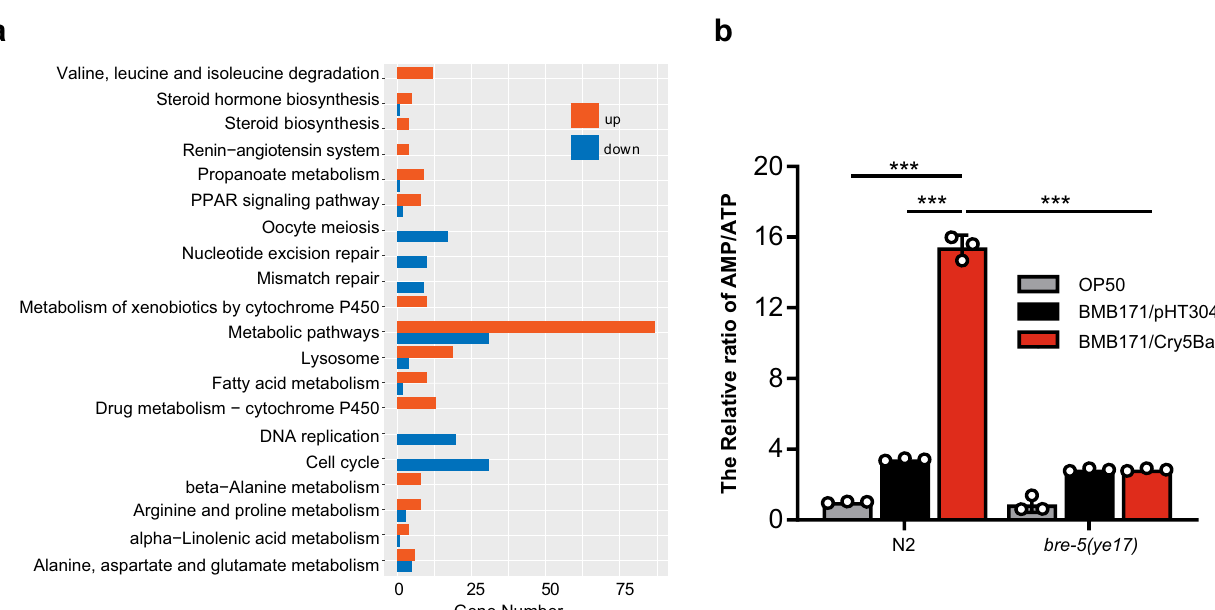
Fig. 1 Nematicidal Bt infection leads to energy imbalance in C. elegans . a An Enrichment Pathway analysis of RNA-Seq data using KOBAS showing the top 20 pathways in fl uenced by nematicidal Bt infection. b Analysis of the AMP/ATP ratio by LC/MS. The wild-type N2 and bre-5(ye17) worms were fed with OP50, BMB171/pHT304, and BMB171/Cry5Ba for 4 h. N = 3 independent experiments. Data points represent the mean values of three independent replicates, error bars denote the SD. The p -value was determined by a Student ’ s t -test (Welch ’ s correction for unequal variances), *** p <